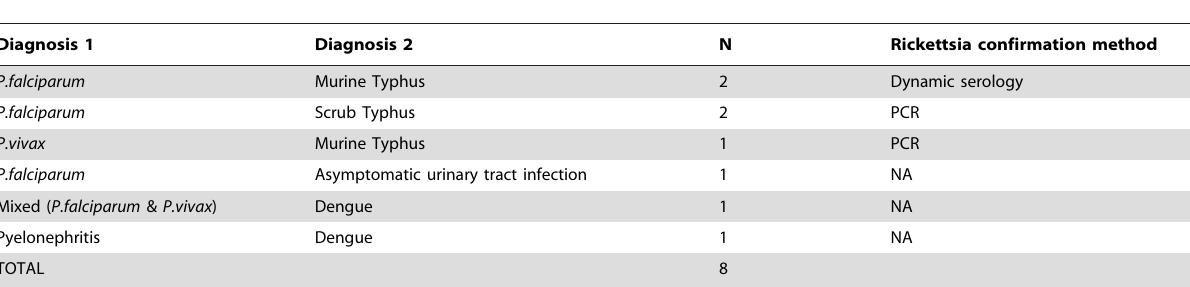
Table 3. Laboratory confirmed diagnosis in women with coinfection.